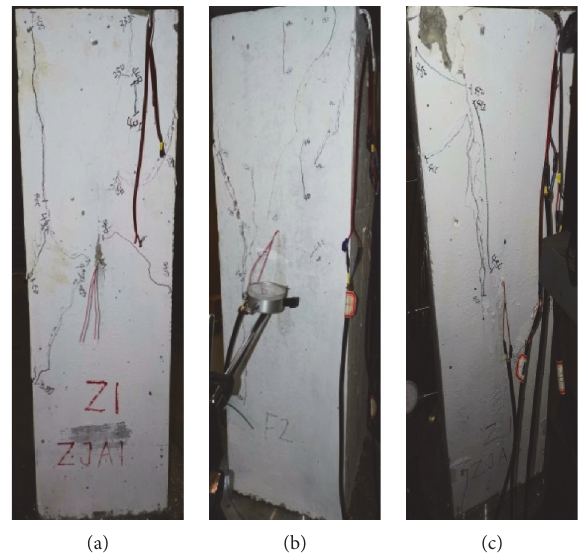
Figure 7: Failure patterns of specimens ZJA: (a) ZJA1, (b) ZJA2, and (c) ZJA3.